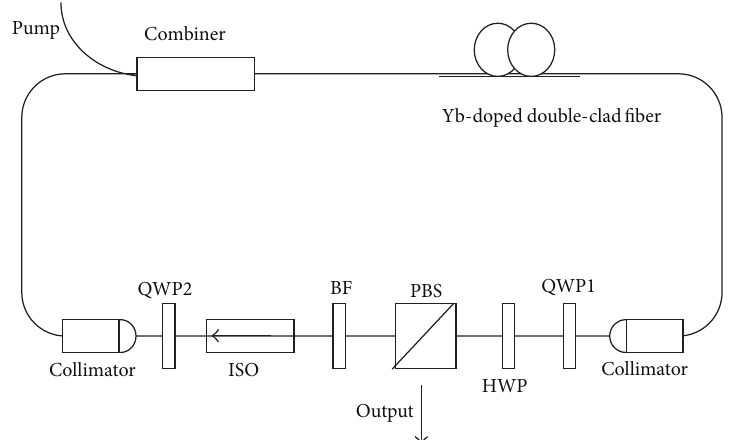
Figure 1: Experimental setup of the Yb-doped double-clad dissipative soliton fiber laser.